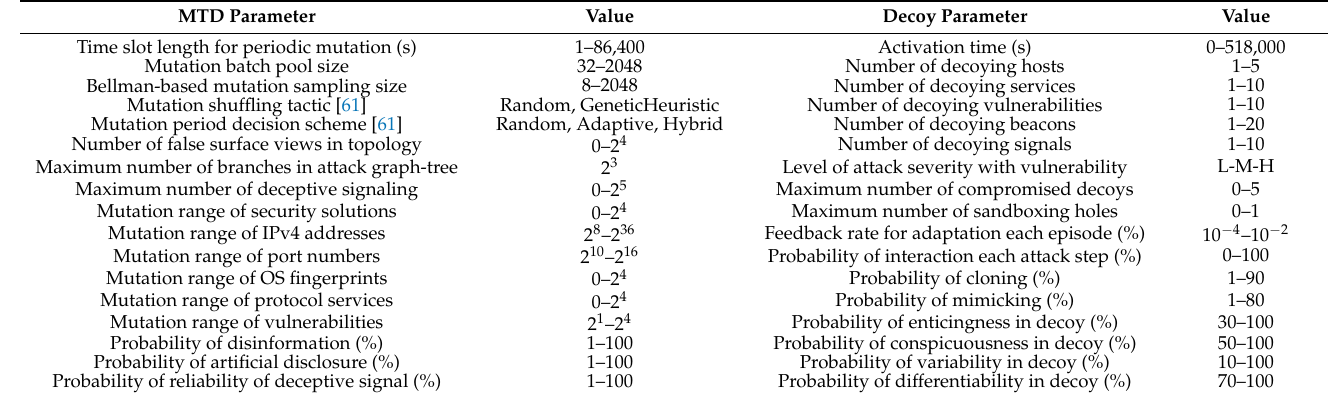
Table A4. The major design parameters, their meanings, and the representative values in IoDM- based testbed.